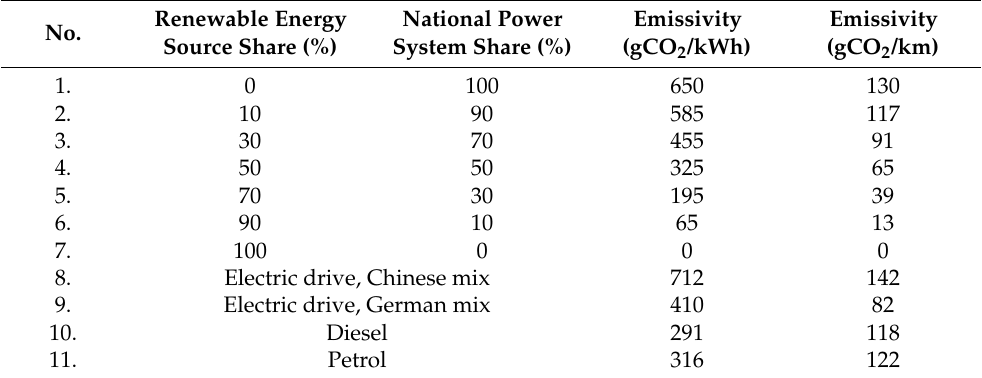
Table 7. Type of a vehicle drive and effects of the CO 2 emission in the environment per road and energy